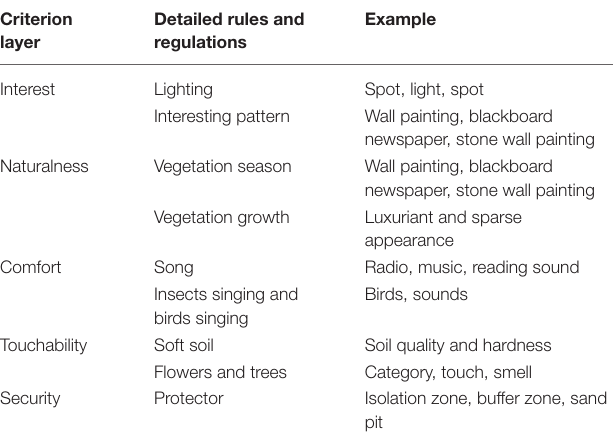
TABLE 7 | SD factor example classification